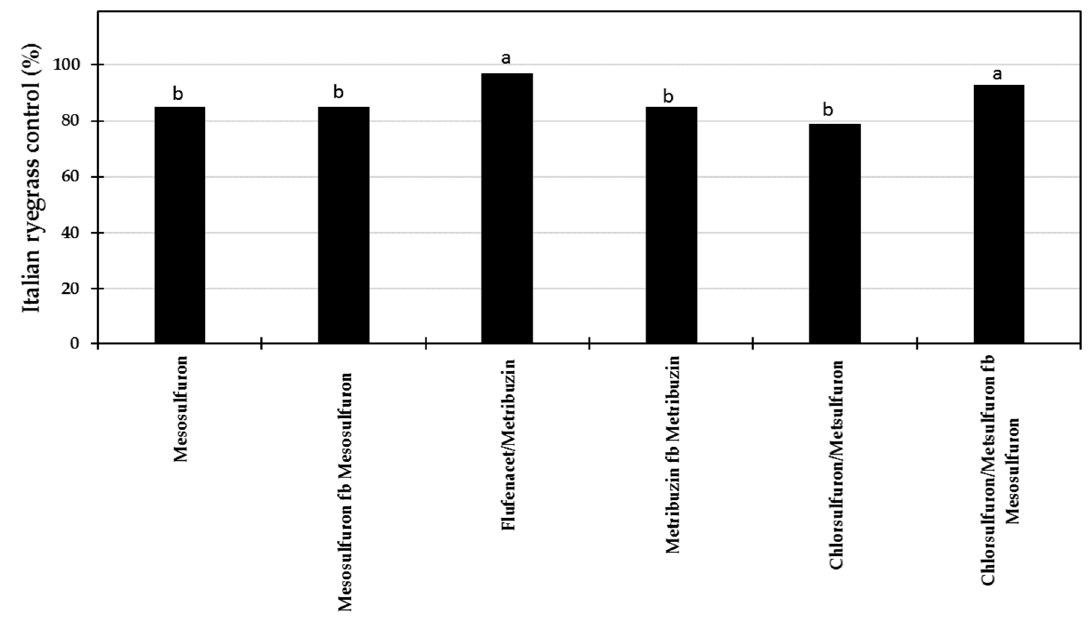
Figure 3. Italian ryegrass control as affected by the herbicide treatments in 2007. Similar letter on bars indicates no statistical difference at p ≤ 0.05. fb means followed by.